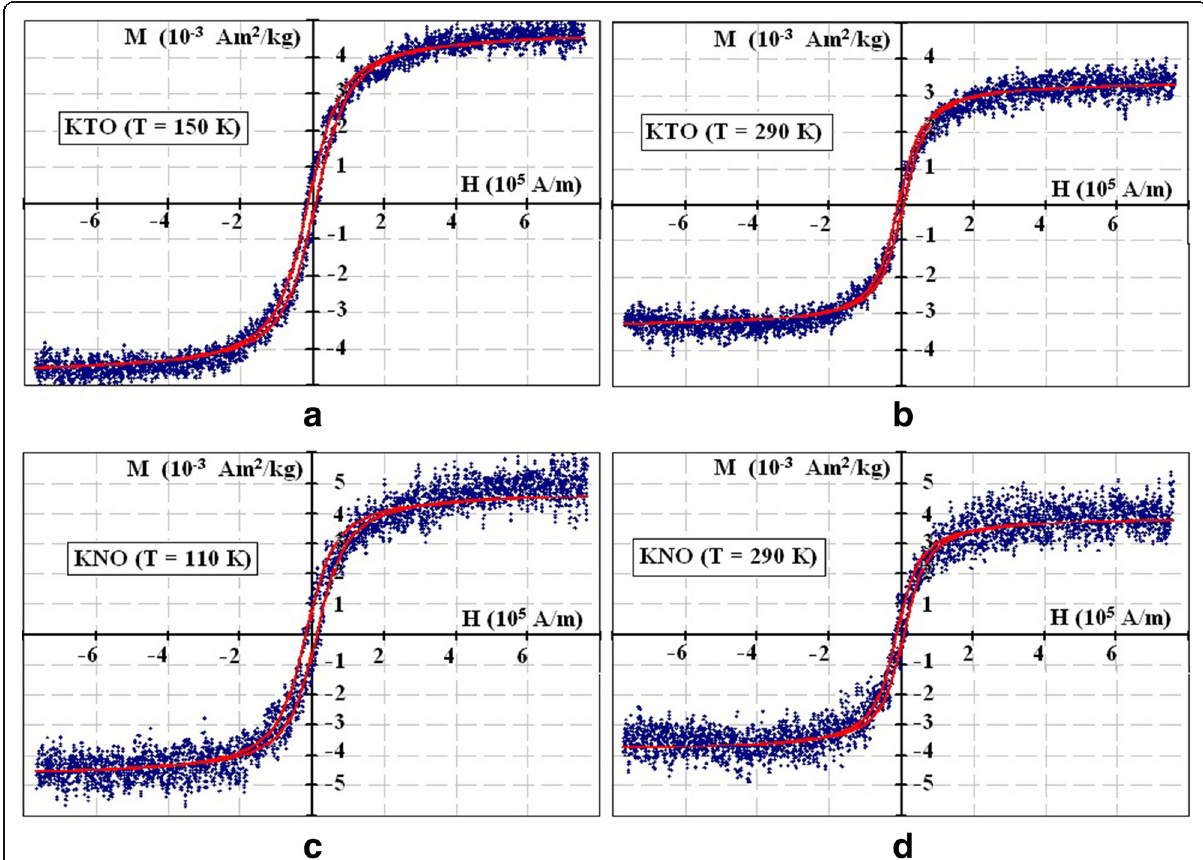
Fig. 3 Static magnetization curves. Magnetization curves in KTaO 3 ( a , b ) and KNbO 3 ( c , d ) nanoparticles at T = 150, 290, 110, and 290 K. Fitting parameters are listed in Table